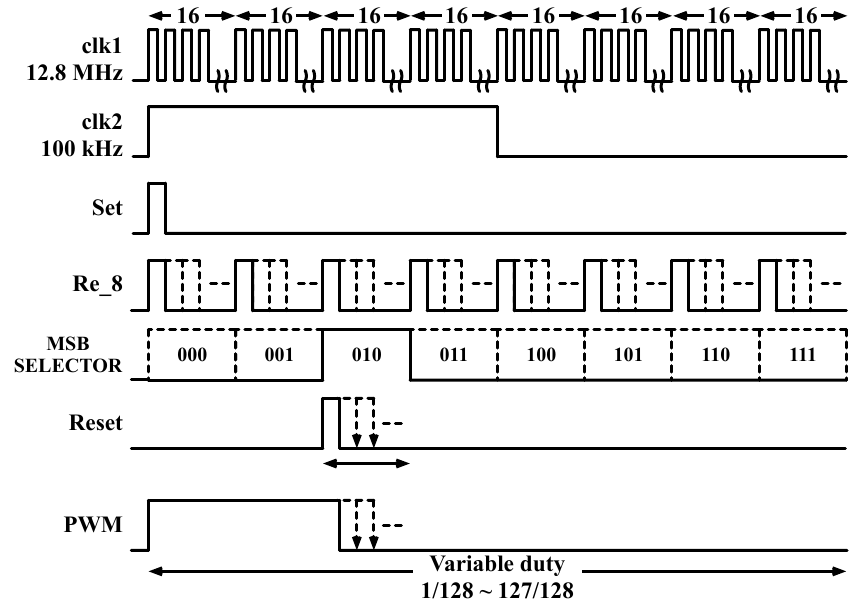
Figure 6. Timing diagram of the proposed